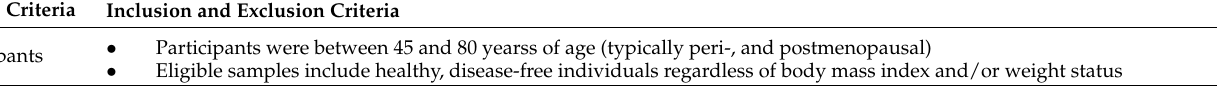
Table 2. The inclusion and exclusion criteria for selecting the studies based on PICOS